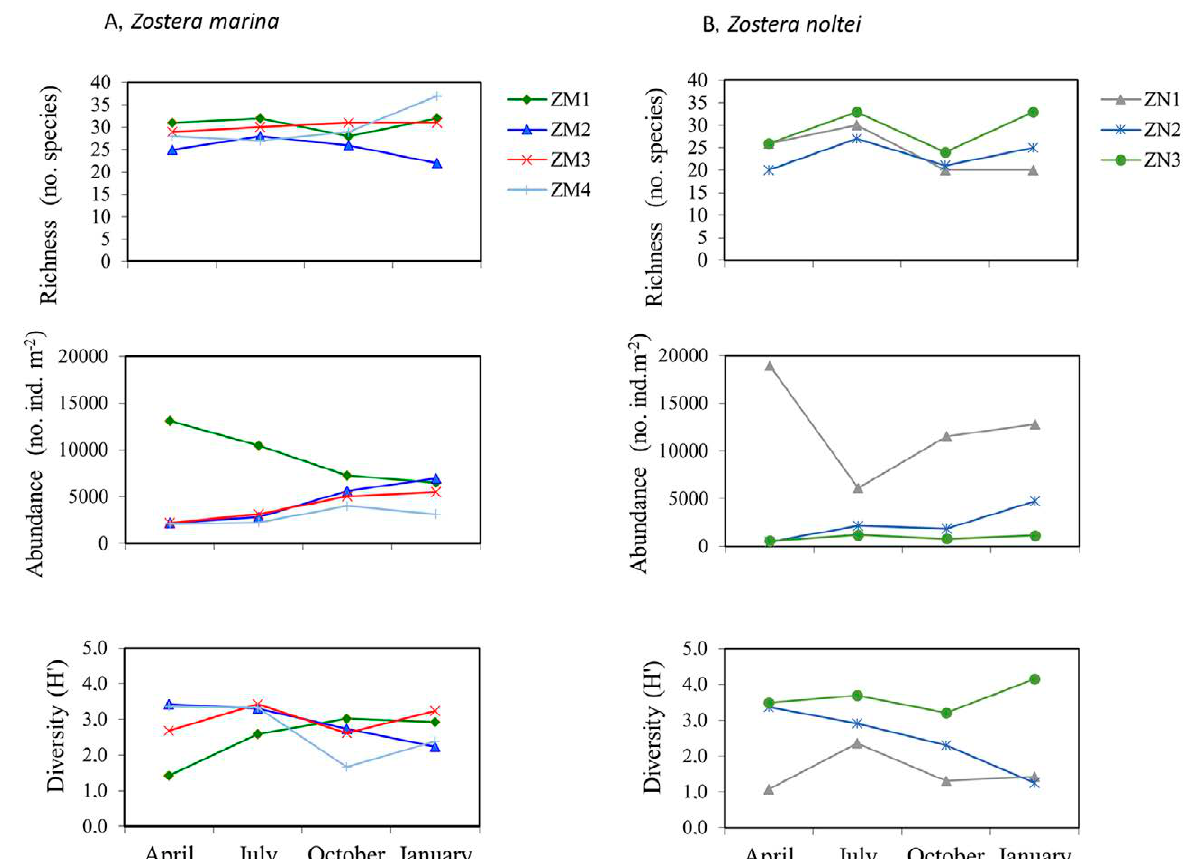
Fig. 5. – Seasonal variation (2000-2001) in the richness (no. species), abundance (ind. m –2 ) and benthic macrofauna diversity (H’) in Zostera marina (ZM1-ZM4) (A) and Zostera noltei (ZN1-ZN3) beds